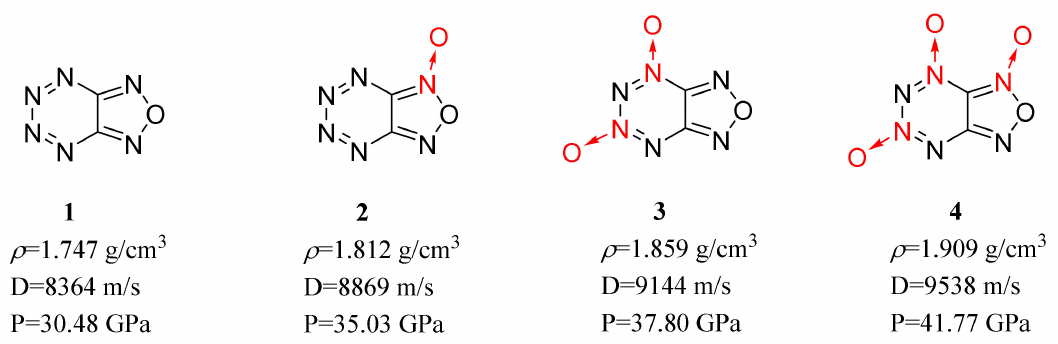
Figure 1. Calculated performance of compounds 1 – 4